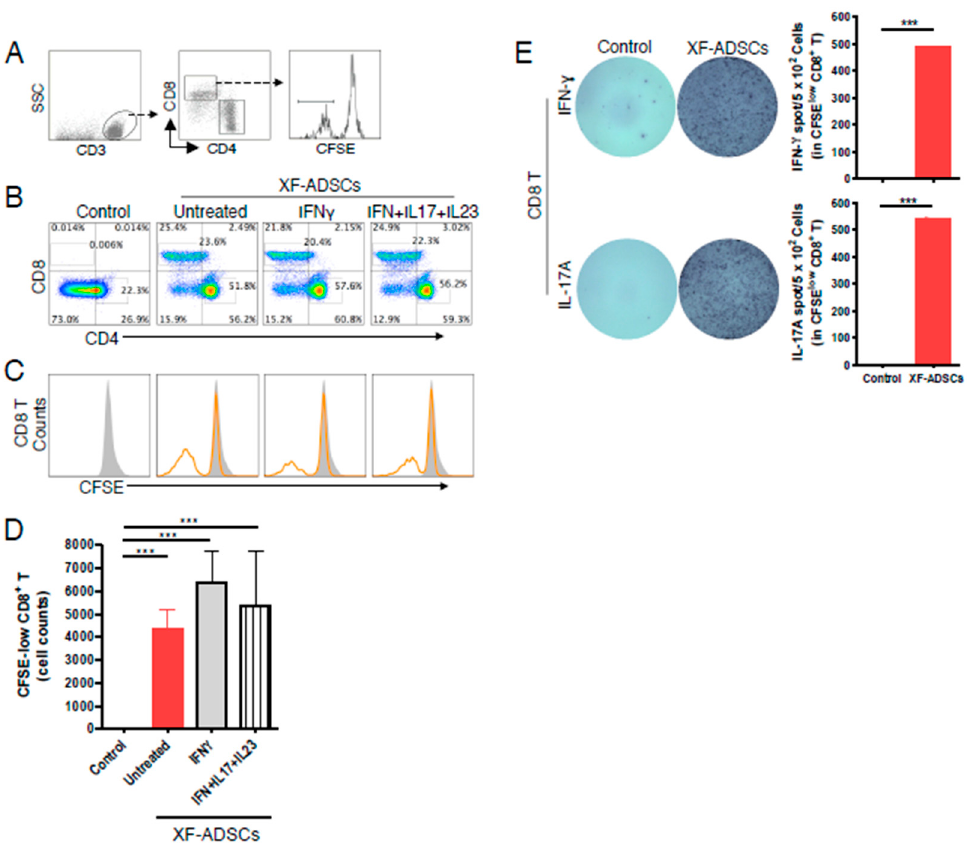
Figure 4. Production of alloreactive CD8 T cells during allogeneic–antigen stimulation. XF-ADSCs were cultured with CD3 T cells and Td-PBMCs via the direct pathway, after 3 weeks whole cells were harvested and CD8 T cells were analyzed by flow cytometry. ( A ) A scheme for the flow cytometry analysis is shown. ( B ) The dot plots indicated the distribution of CD4 T and CD8 T cells on day 21 after allogeneic–antigen stimulation compared with the control ( n = 9 (for each sample)). ( C ) The histogram showed the CFSE-low-CD8 T cells in the CD8 T cell distribution of (b). ( D ) Graphical representation of the number of CFSE-low CD8 T cells corresponding to (C) ( n = 16 (control), n = 14 (for each sample)). ( E ) For ELISPOT analysis, XF-ADSCs were cultured with CD8 T cells and Td-PBMCs via the direct pathway. After 2 weeks, whole cells were harvested and plated in quadruplicate on a 96-well filter plate ( n = 4 (for each sample)). Spots of IFN- γ or IL-17A secreted by CD8 T cells were analyzed by ELISPOT. The controls do not contain XF-ADSCs and consist only of CD3 T cells (or CD8 T) and Td-PBMCs from healthy donor. The data were repeated at least three times; ***, p < 0.001.